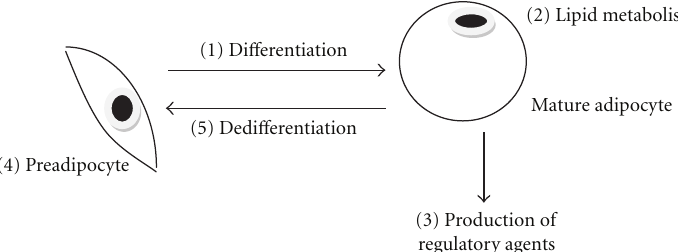
Figure 2: Strategic points in which the study of adipocytes will prove fruitful for obesity and metabolic-related problems. Traditional areas of concentrated research have focused on cell di ff erentiation to form lipid-assimilating adipocytes (1), lipid metabolism under a variety of physiologies and nutrient loads (2), and (more recently) adipocyte production of local and systemic regulatory agents (3). However, new targets like deciphering the potential mechanisms of mature adipocyte dedi ff erentiation (5) to form proliferative-competent progeny cells like additional preadipocytes (4) are being carefully